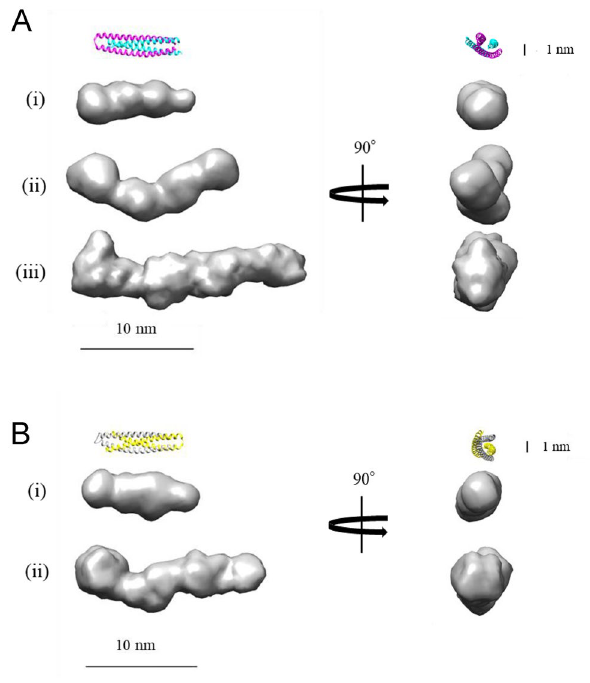
Figure 5. Dummy atom model shapes of the ROWA and ROSA oligomers. ( A ) Dummy atom models of the ROWA (i) dimer, (ii) tetramer, and (iii) hexamer. ( B ) Dummy atom models of the ROSA (i) dimer and (ii) tetramer. The models were constructed based on the SAXS data using the ab initio modelling programs DAMMIF 40 , DAMAVER 41 , and DAMMIN 42 without symmetry constraints. Ribbon representations of the crystal structures of WA20 (PDB ID: 3VJF) 16 and SUWA (PDB ID: 6KOS) 20 are shown as references. These images were created using UCSF Chimera 43 , version 1.12 (https:// www. cgl. ucsf. edu/ chime ra/). The SAXS data and dummy atom models have been deposited into SASBDB 44,45